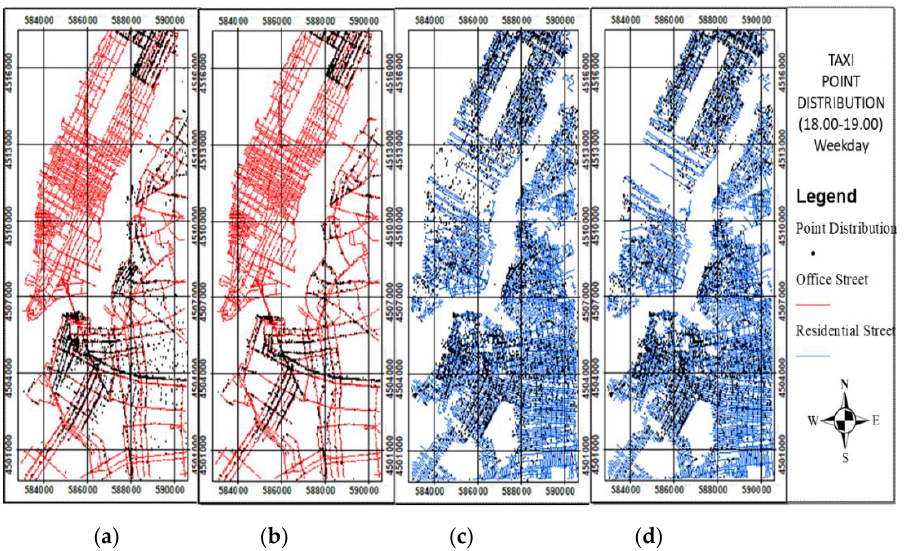
Figure 12. Taxi point distribution at the second weekday peak time (18:00 – 19:00): ( a ) origin before data cleaning; ( b ) origin after data cleaning. ( c ) destination before data cleaning; ( d ) destination after data cleaning.